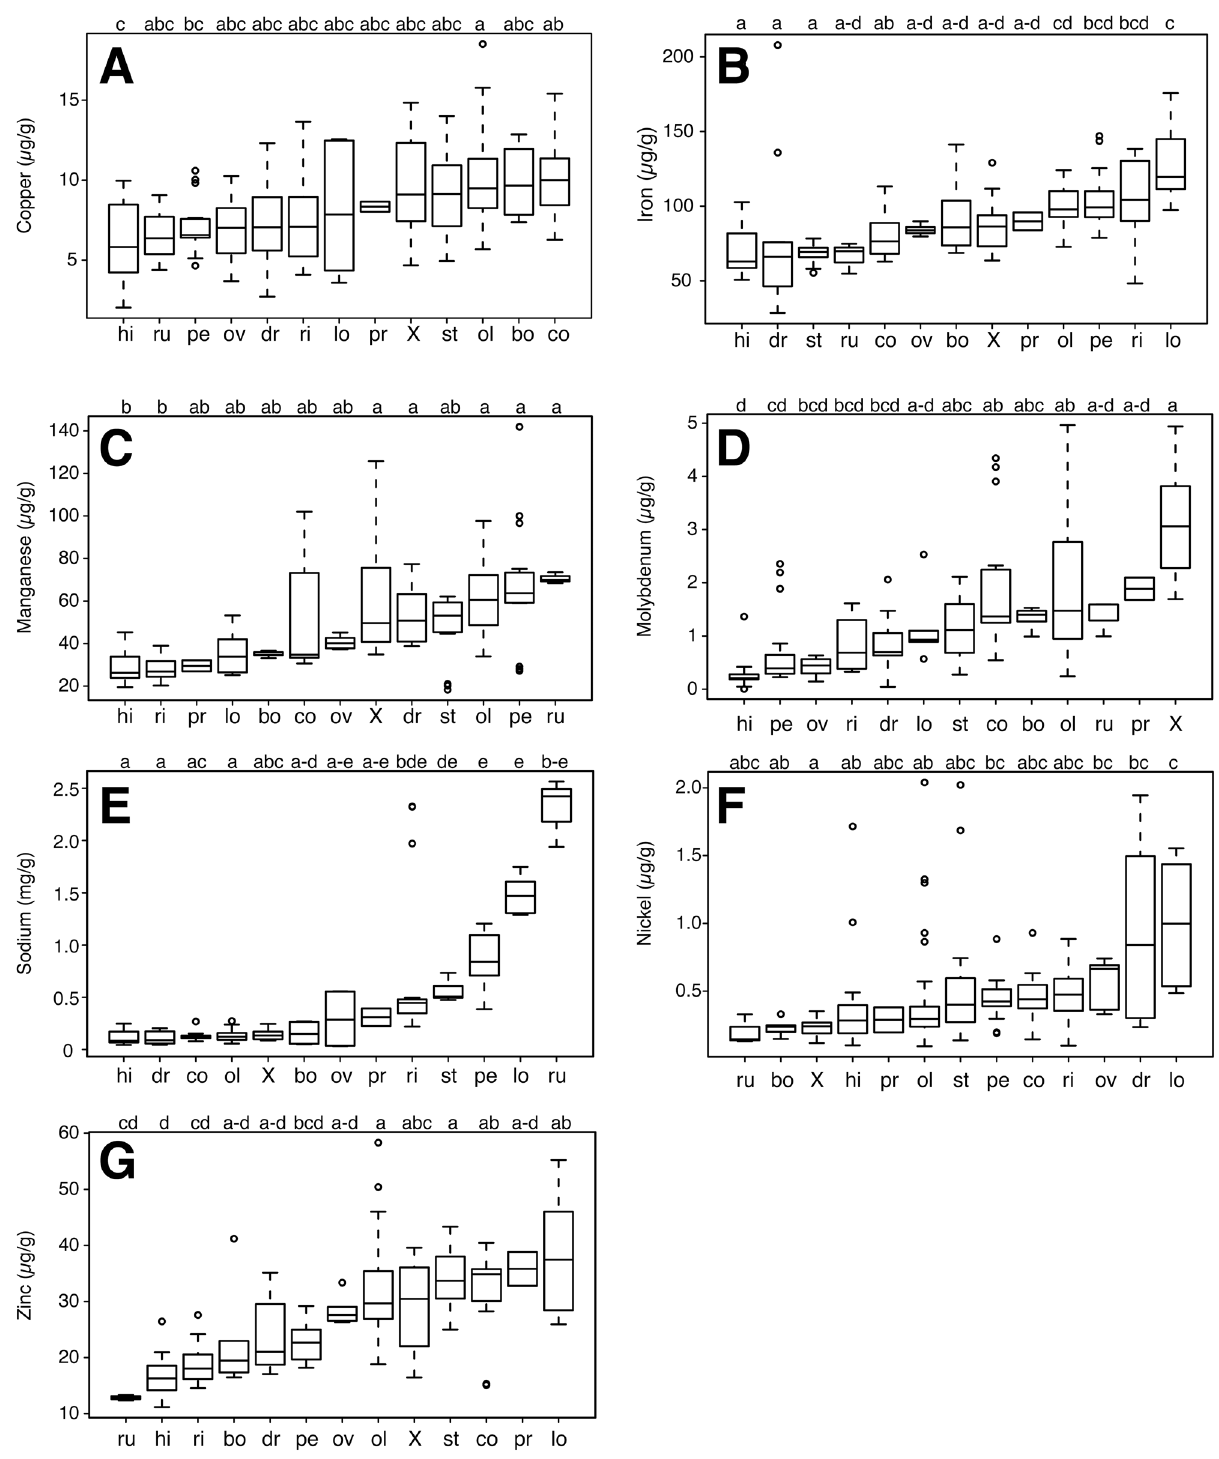
Fig 2. Boxplots and homogeneous groups for micronutrients. (A) Cu, (B) Fe, (C) Mn, (D) Mo, (E) Na, (F) Ni, (G) Zn. Boxplots are based on the median. Abbreviations and conventions as in Fig 1.